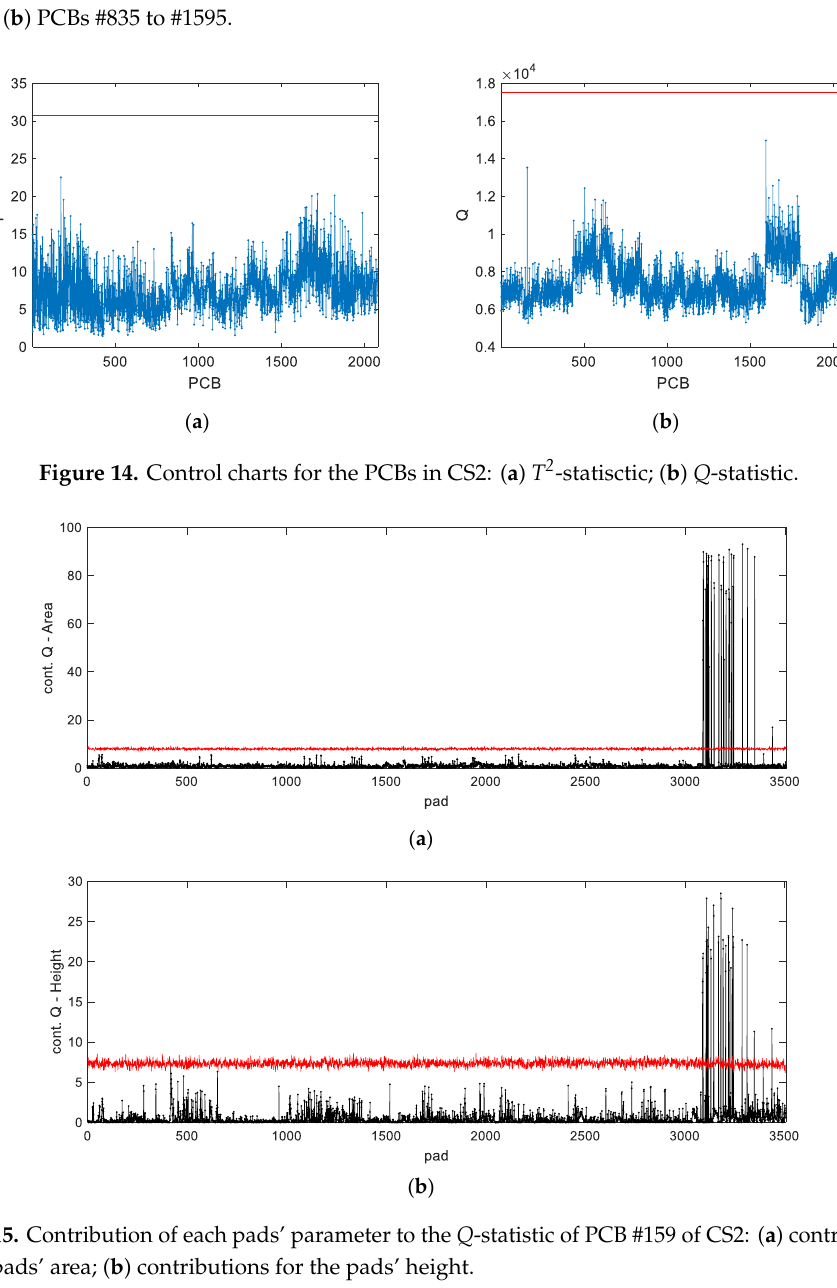
Figure 13. Second and fifth principal components of CS2 stratified by printing direction: ( a ) PCBs #435 to #834. ( b ) PCBs #835 to #1595.